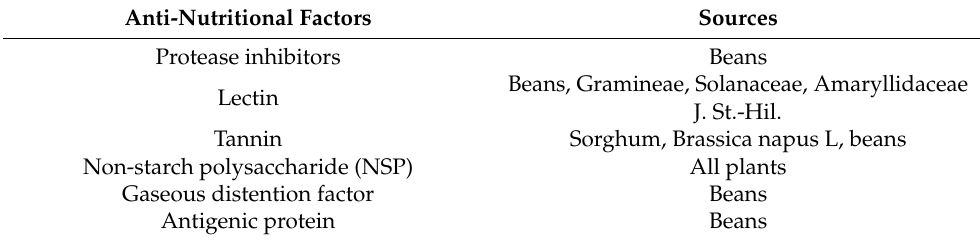
Table 2. Anti-nutritional factors on agro-industry by-products ingredients. Anti-Nutritional